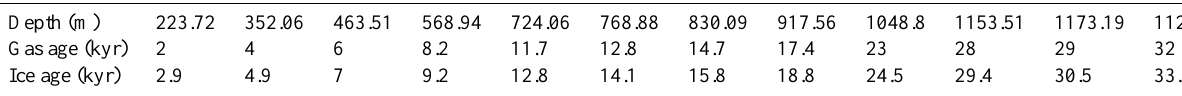
Table 3. Depth–age tie points for EDML. Depth (m)